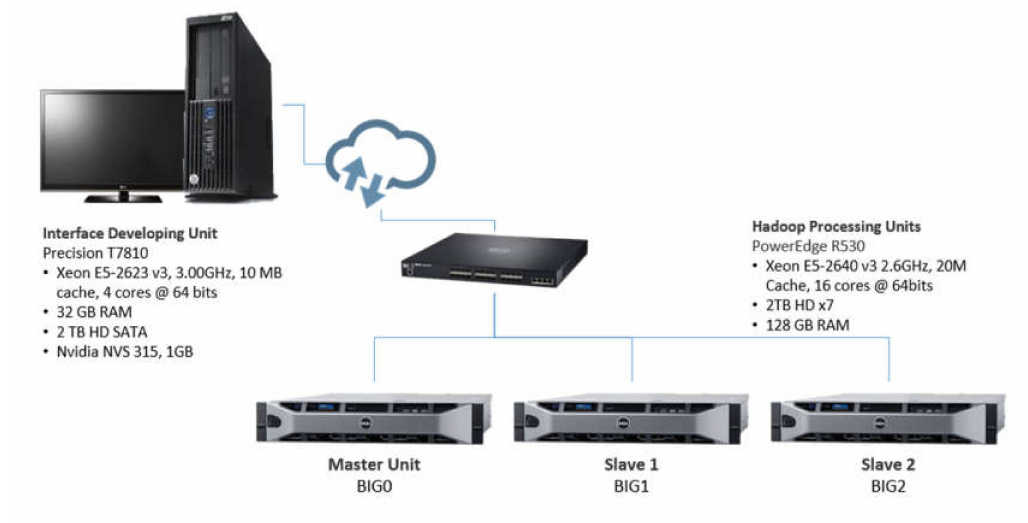
Figure 2. Data framework allocated for the case